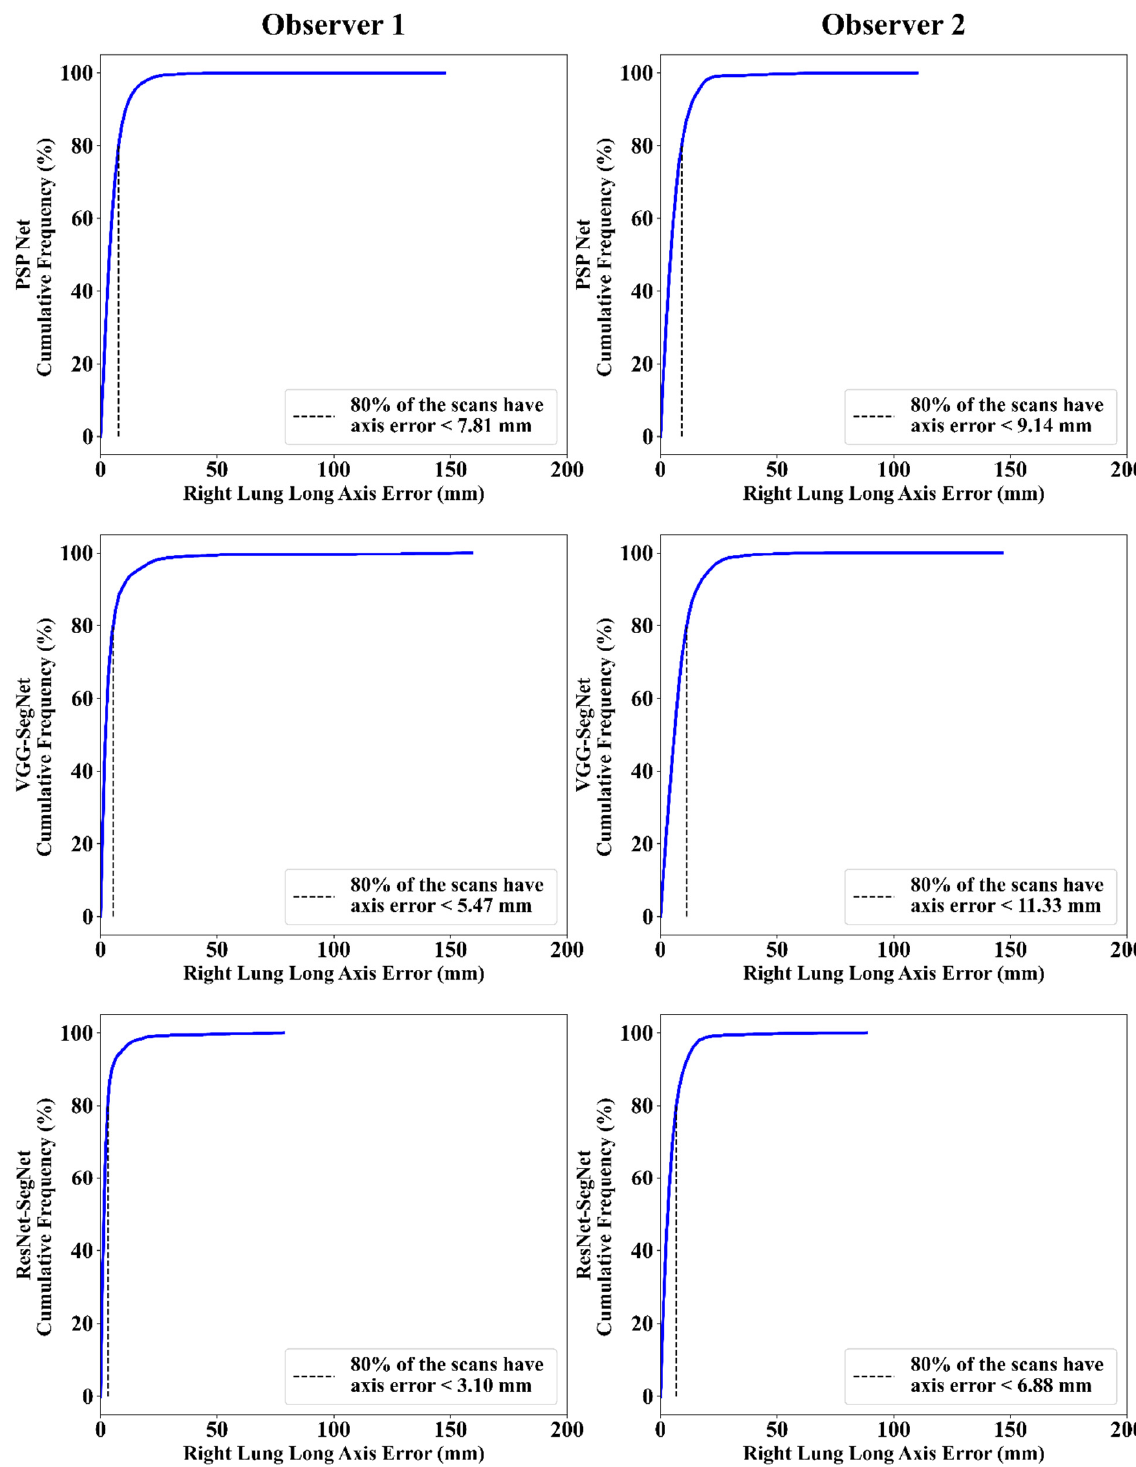
Figure 22. Cumulative frequency plot for right LLAE using three AI models: Observer 1 vs. Observer 2.